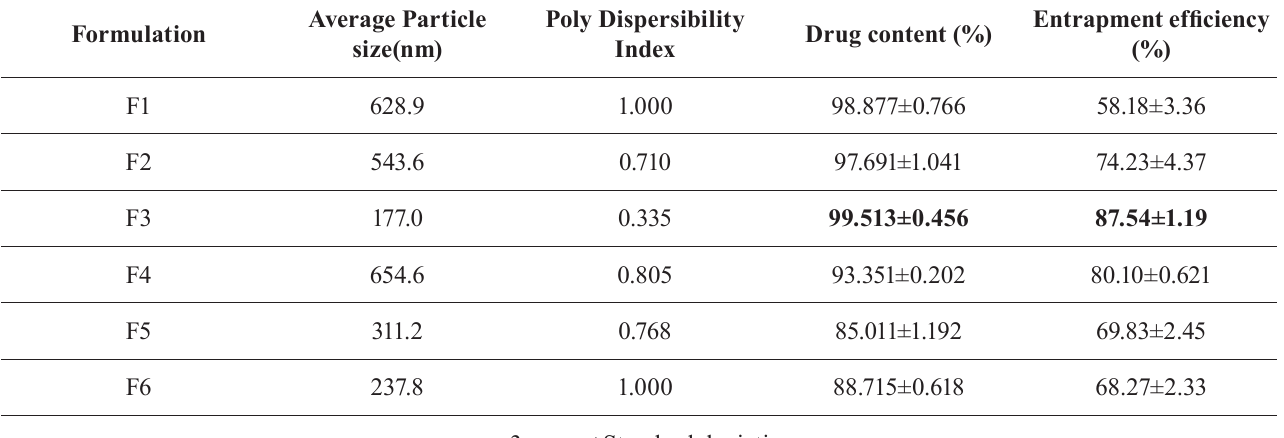
TABLE II - Particle size, Polydispersibility Index, Drug content and Entrapment efficiency of formulated